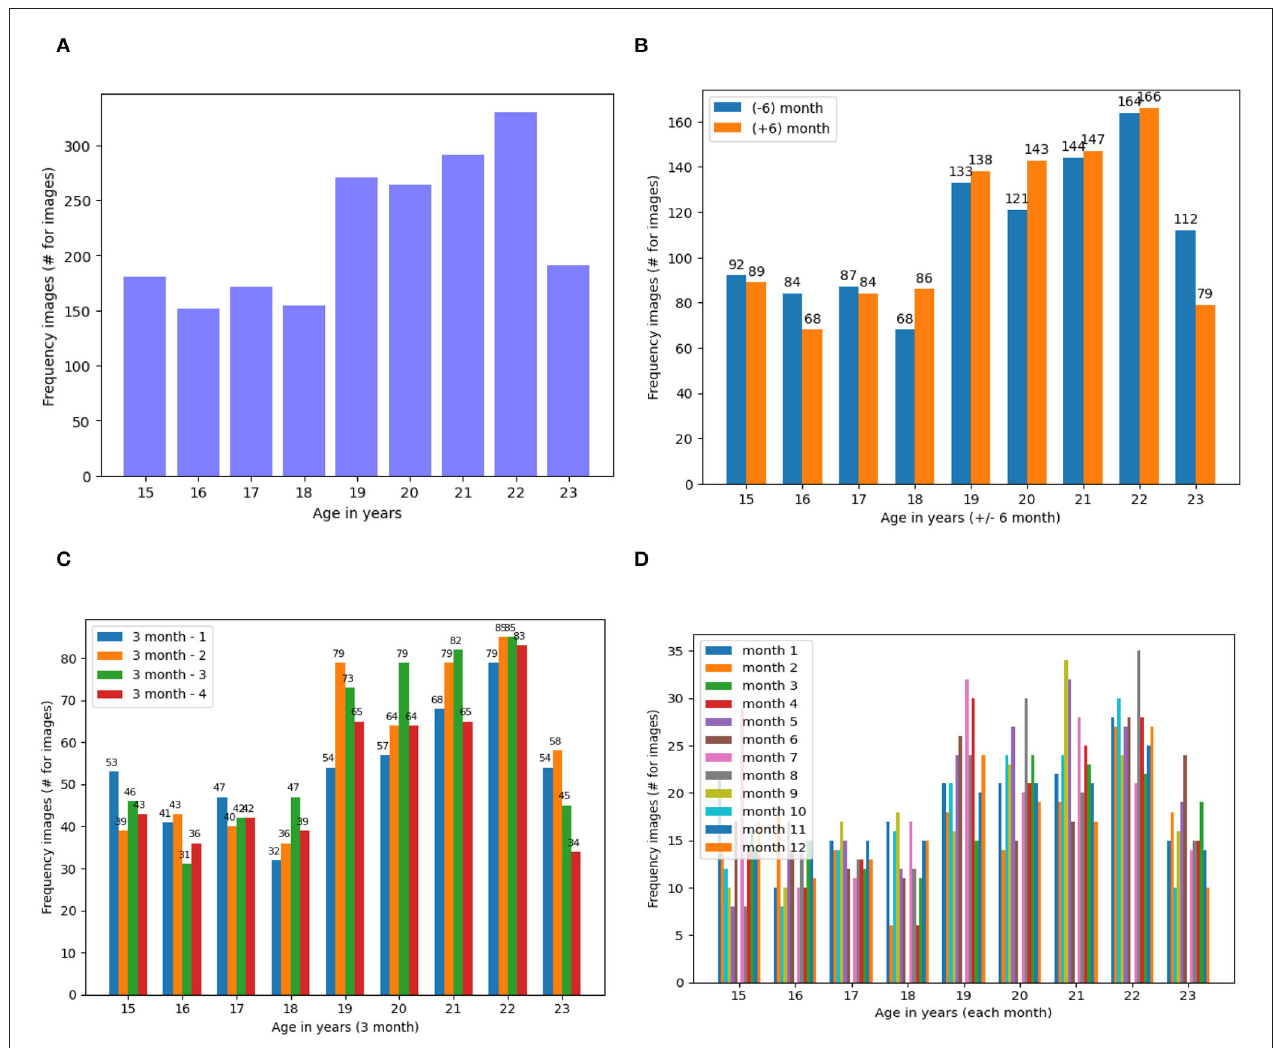
FIGURE 4 | Frequency of Dataset Images Based on the Four States of the Dataset (A) Dataset on Year, (B) . On ± 6-Month, (C) . On ± 3 Month and (D) . On ± 1 Month. (A) Frequency of dental images for years dataset. (B) Frequency of dental images for ± 6 months dataset. (C) Frequency of dental images for ± 3 months dataset. (D) Frequency of dental images for ± 1 months dataset.